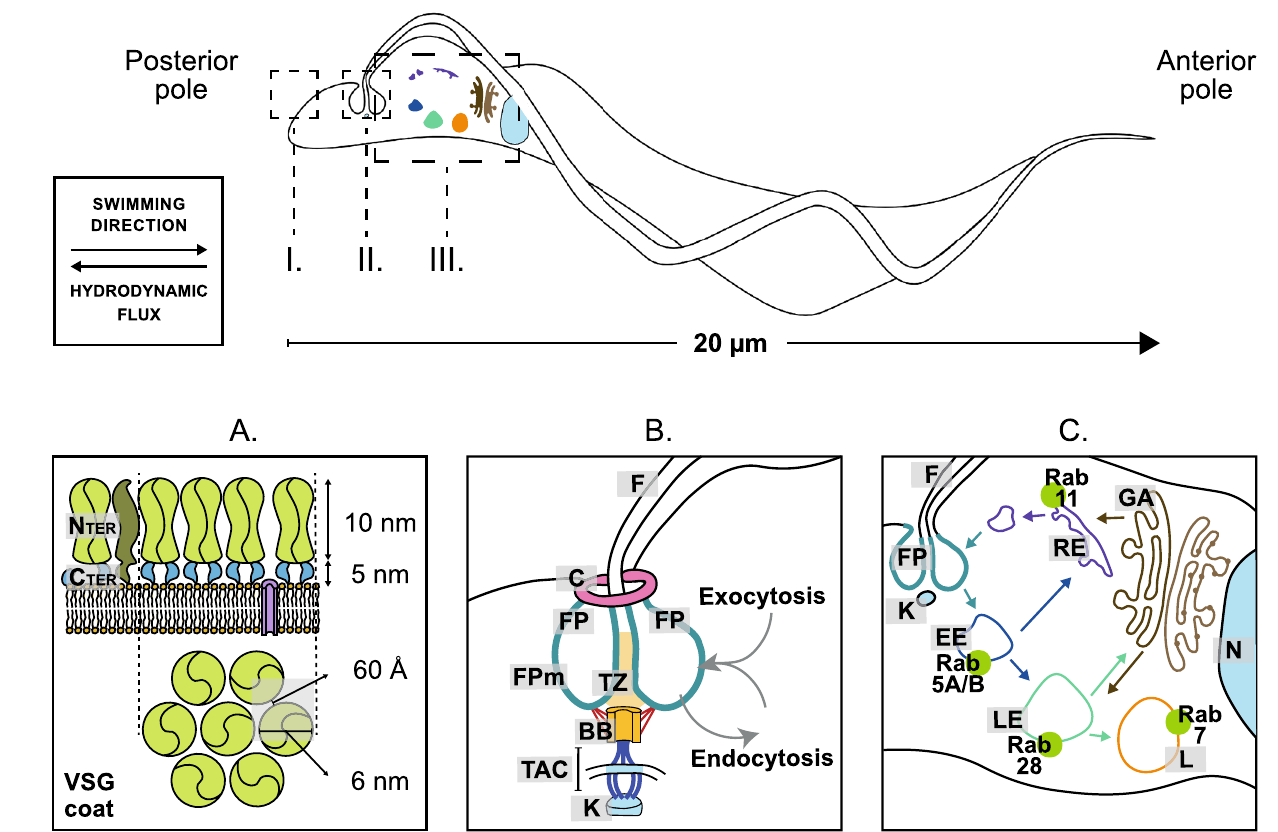
Figure 1. T. brucei morphology: ( A ) VSG coat structure. The plasma membrane is covered by a densely packed VSG coat. VSG constitutes over 95% of the surface coat components 2 . ( B ) Flagellar pocket structure 5 . The flagellar pocket (FP) is the sole site of endo- and exocytosis. This invagination is structured by a highly specialised membrane (FPm) penetrated by the flagellum (F) and stabilised by the flagellar pocket collar (C). The flagellum is attached to the cell body by the basal body (BB), which is connected by the tripartite attachment zone to the kinetoplast (K), the kinetoplastids’ unique organelle. ( C ) Endocytosis and exocytosis pathways in T. brucei 2,3 . Cargo is endocytosed in the flagellar pocket. The invaginated vesicles fuse to the Rab5A/B +